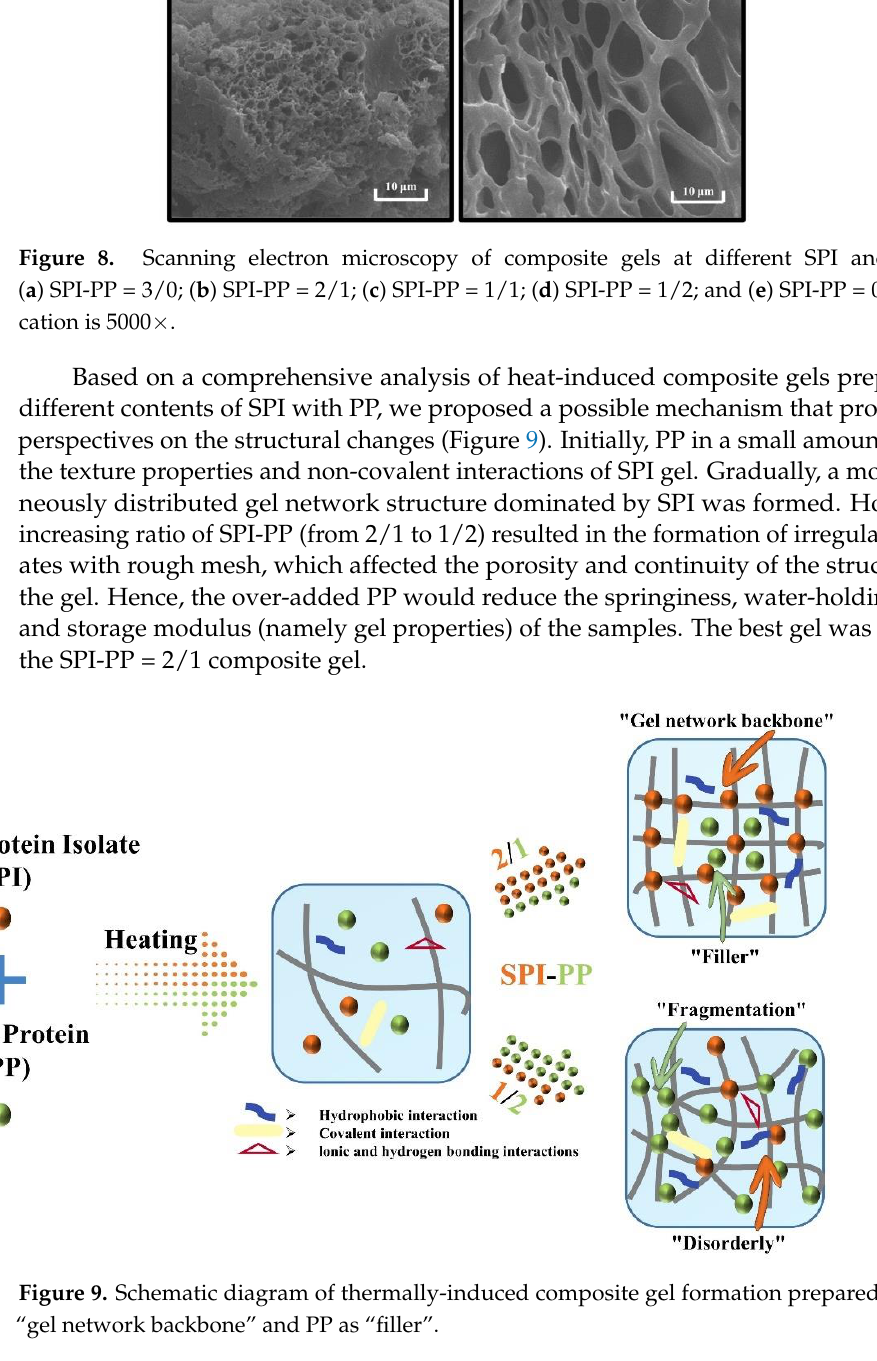
Figure 9. Schematic diagram of thermally-induced composite gel formation prepared from SPI as “gel network backbone” and PP as “filler”. “gel network backbone” and PP as